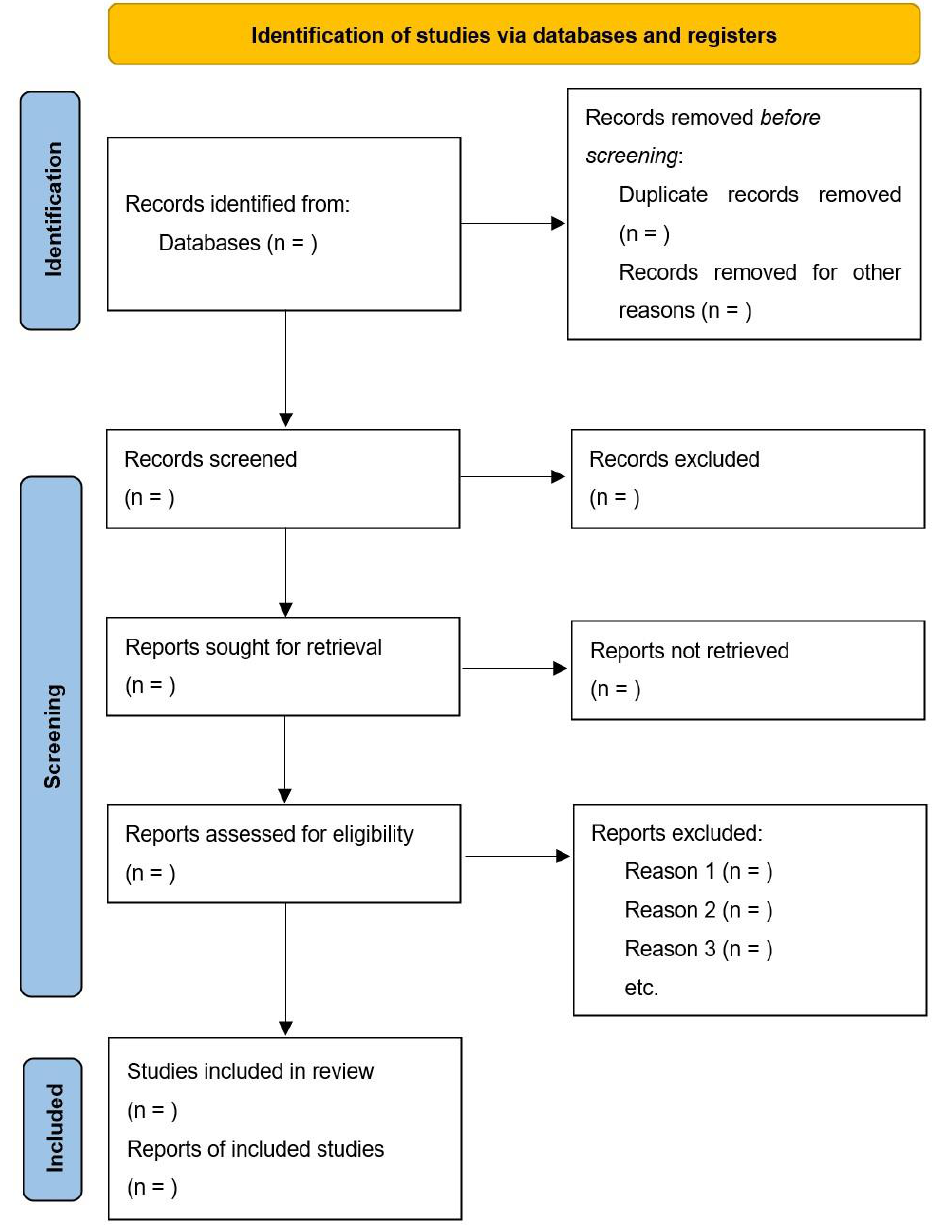
Figure 1. PRISMA 2020 Flow Diagram for New Systematic Reviews.